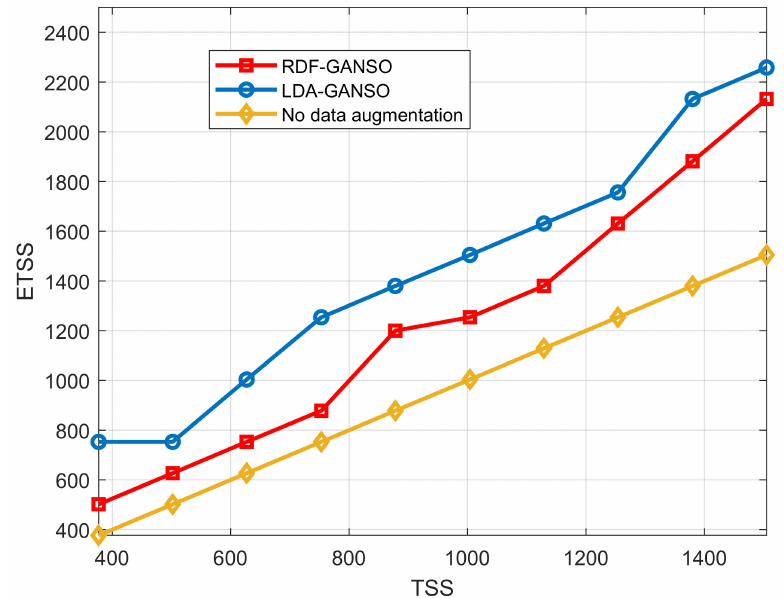
Figure 5. Effective training set size ( ETSS ) for a given training set size ( TSS ), with data augmentation (RDF-GANSO, LDA-GANSO) and with no data